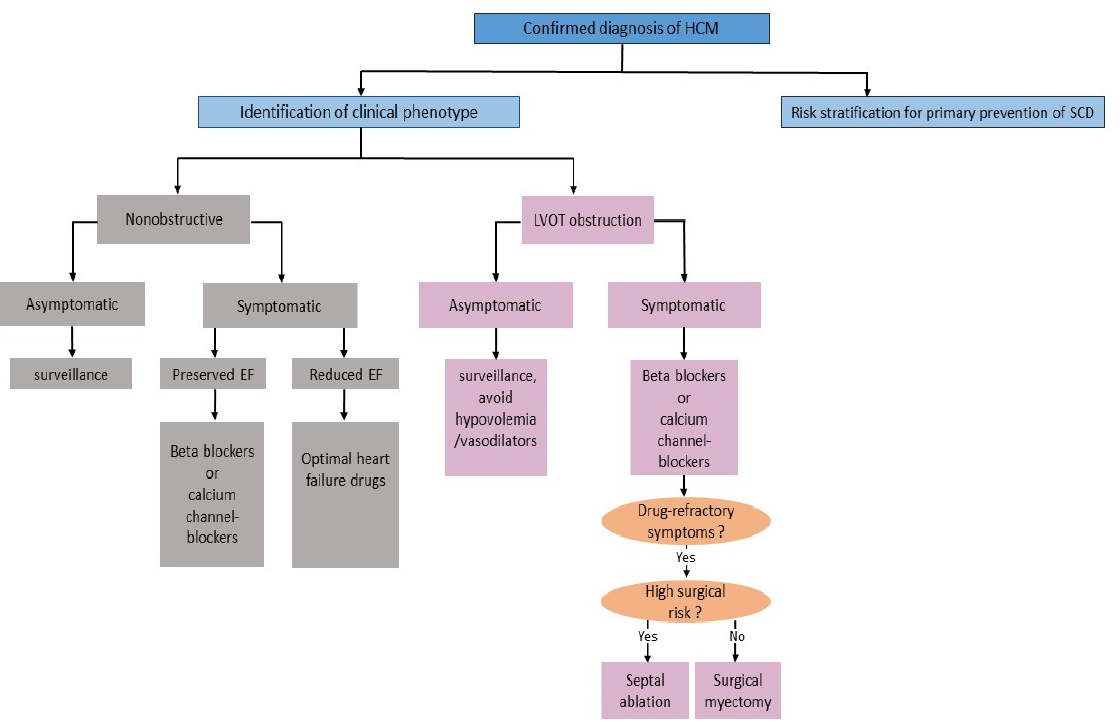
Figure 1. Problem-oriented management of HCM based on clinical phenotype and stage of disease. HCM: hypertrophic cardiomyopathy; SCD: sudden cardiac death; EF: ejection of fraction; LVOT: left ventricular outflow